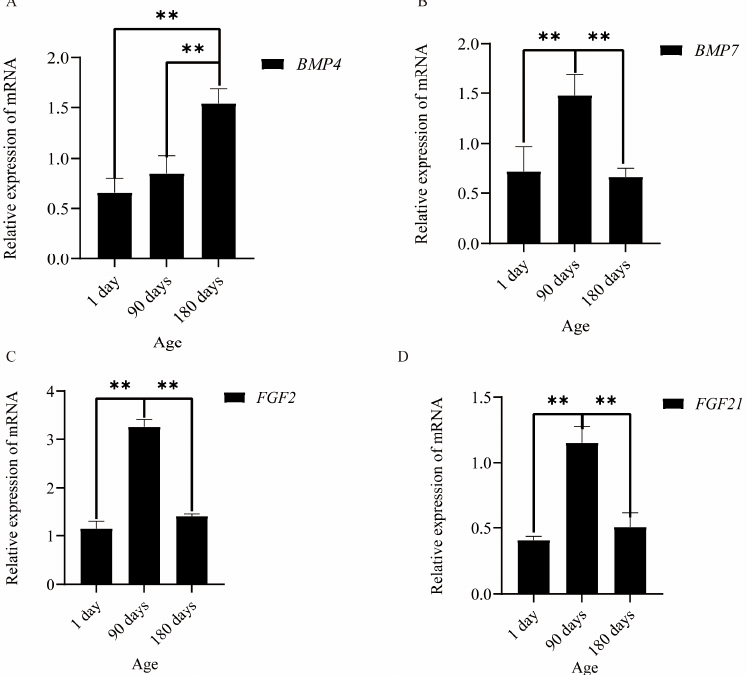
Figure 2. ( A – D ) represent the expression of BMP4 , BMP7 , FGF2 , and FGF21 at different time points Figure 2. Figures ( A ), ( B ), ( C ), and ( D ) represent the expression of BMP4 , BMP7 , FGF2 , and FGF21 ( n = 5); Data are presented as least squares means ± SEM; ** signifies a highly significant difference at different time points ( n = 5); Data are presented as least squares means ± SEM; * signifies a signif- at p ≤ icant difference at p ≤ 0.05; ** signifies a highly significant difference at p ≤ 0.01.